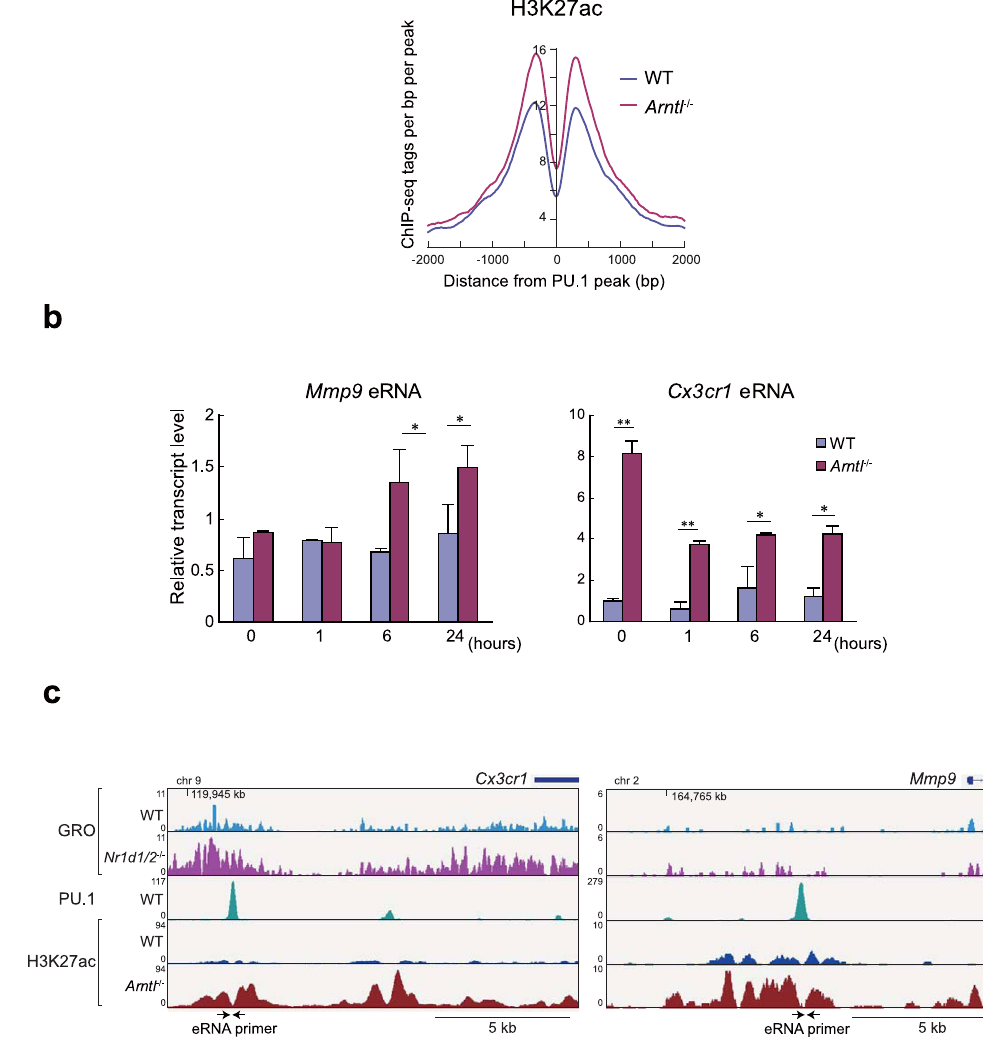
Figure 8. RevErb-dependent eRNA transcription was de-repressed in Arntl − / − macrophages. ( a ) Average H3K27ac read density around PU.1 binding sites adjacent to the RevErb-regulated eRNA-expressing enhancers in WT and Arntl − / − macrophages at steady state. ( b ) qPCR analysis of eRNAs transcribed at the Mmp9 and Cxcr1 enhancers. eRNA expression was compared between WT and Arntl − / − macrophages treated with KLA for indicated times. n = 3 for each group at each time point. * p < 0.05 between WT and Arntl − / − at the same time point. ( c ) Genome browser snapshots of GRO-seq signals in WT and Nr1d1 / Nr1d2 double knockout cells, and ChIP-seq signals for PU.1 and H3K27ac in WT and Arntl − / − cells at steady